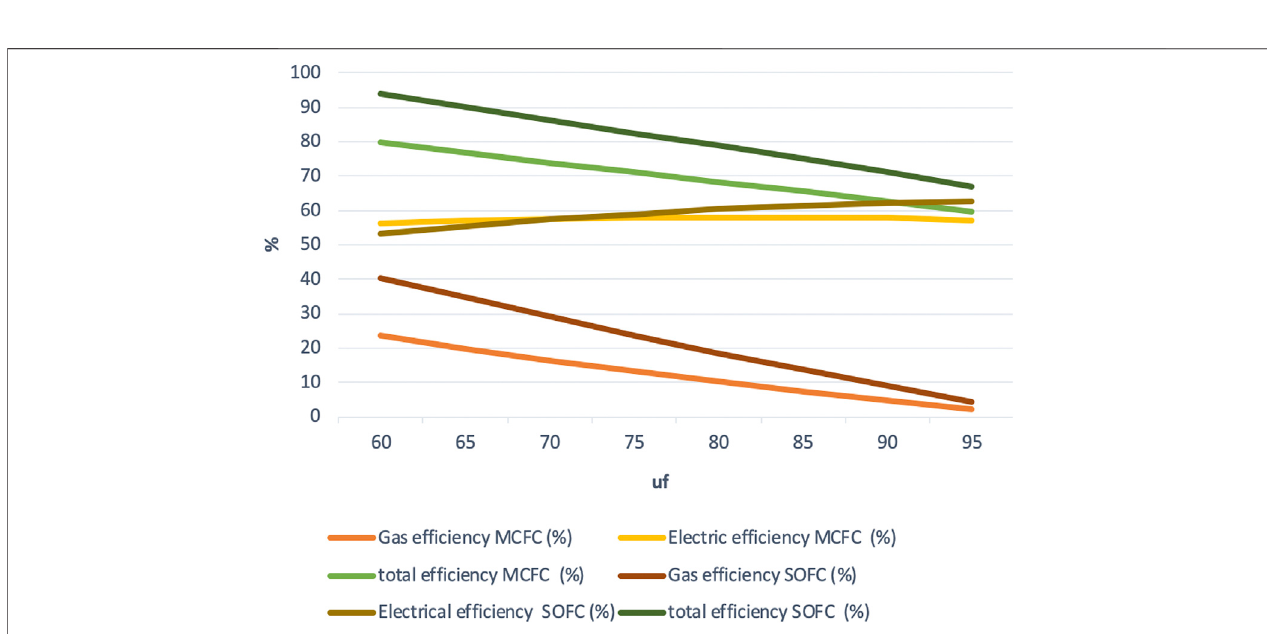
FIGURE 3 | Ef fi ciency vs. fuel utilization for high-ef fi ciency